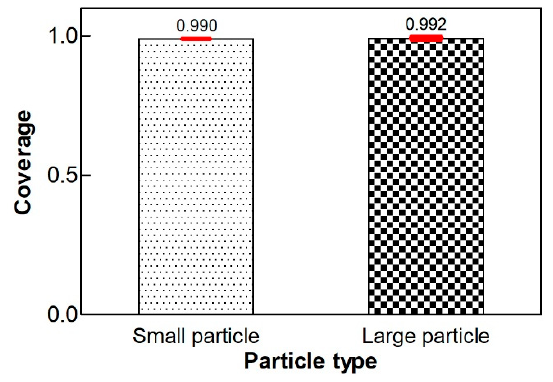
Figure 8. Coverage comparison based on particle size.